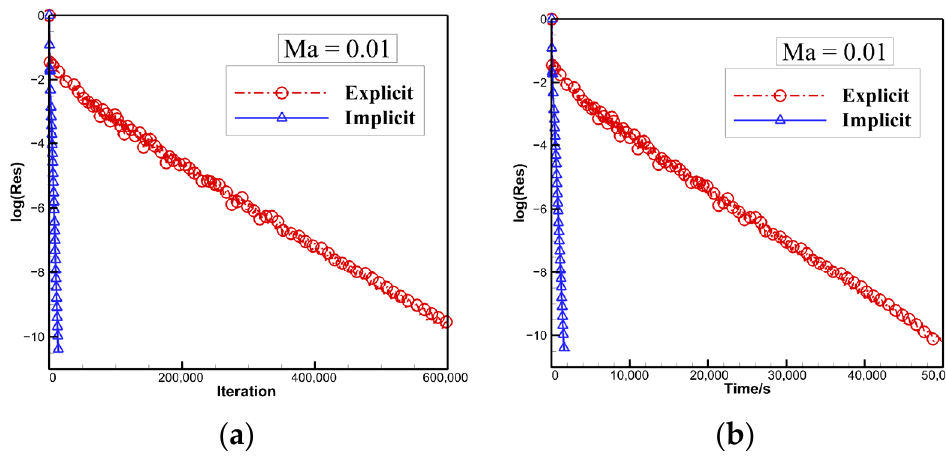
Figure 10. Comparisons of convergence histories. ( a ) Vs iteration; ( b ) Vs time.